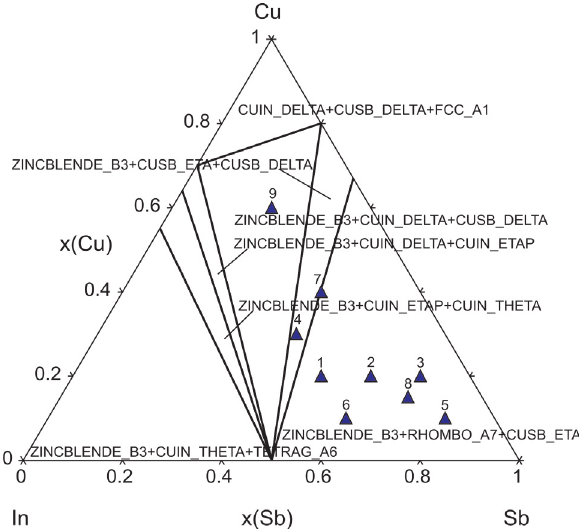
Figure 3. Isothermal section at 298 K of the ternary Cu-In- Sb system.